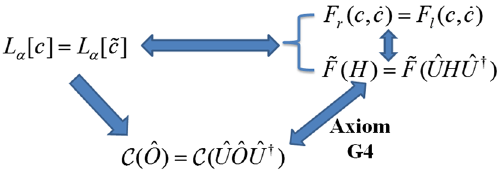
Fig. 5 Equivalences between (i) the unitary-invariance of QFT, (ii) the independence of the Finsler metric on the left/right generators, and (iii) the adjoint invariance of the